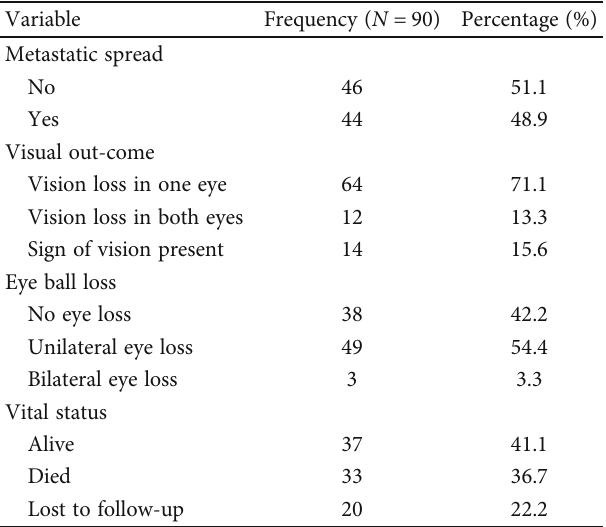
Table 3: Outcomes of children with retinoblastoma at the last follow-up